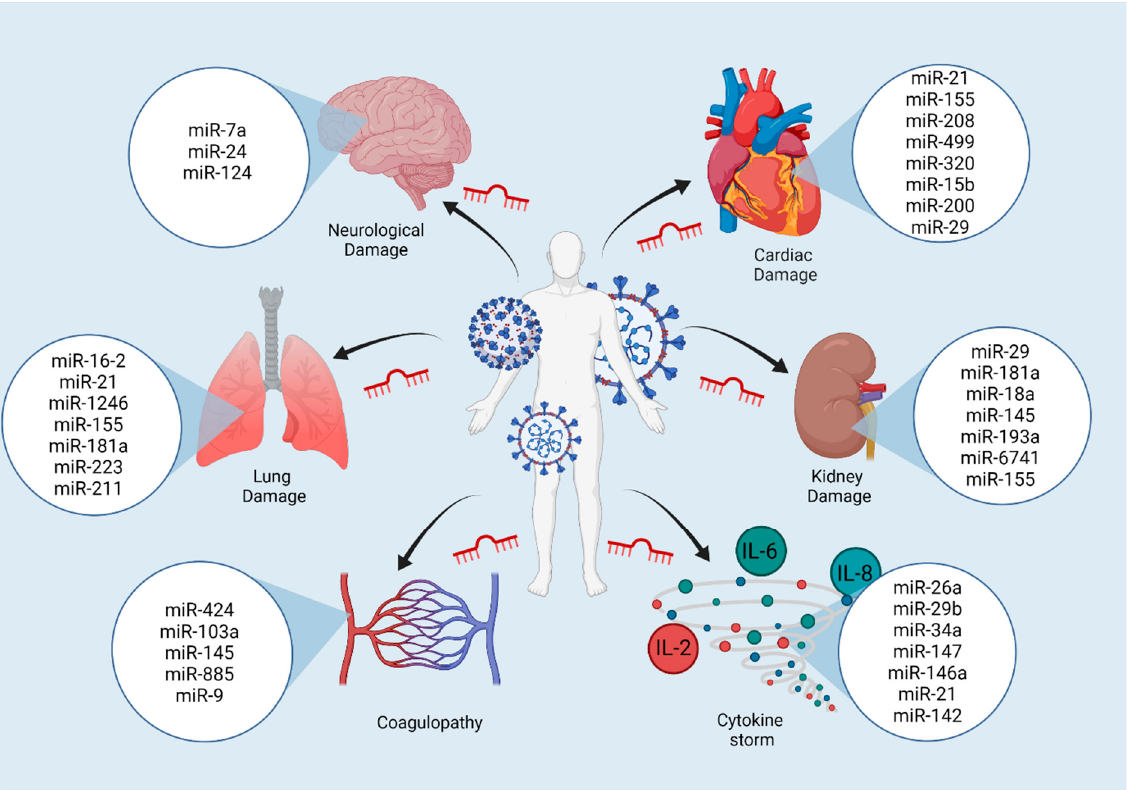
Figure 3. miRNAs involved in the main clinical complications of COVID ‐ 19. Created with BioRender.com.